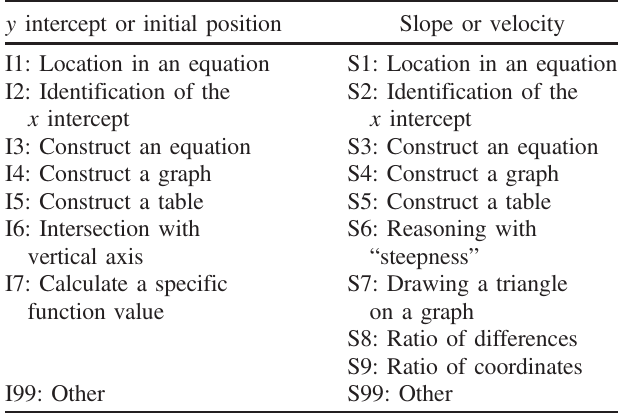
TABLE III. Bottom-up constructed categorization scheme. y intercept or initial